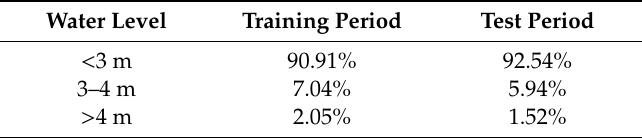
Table 1. Distribution of water level by